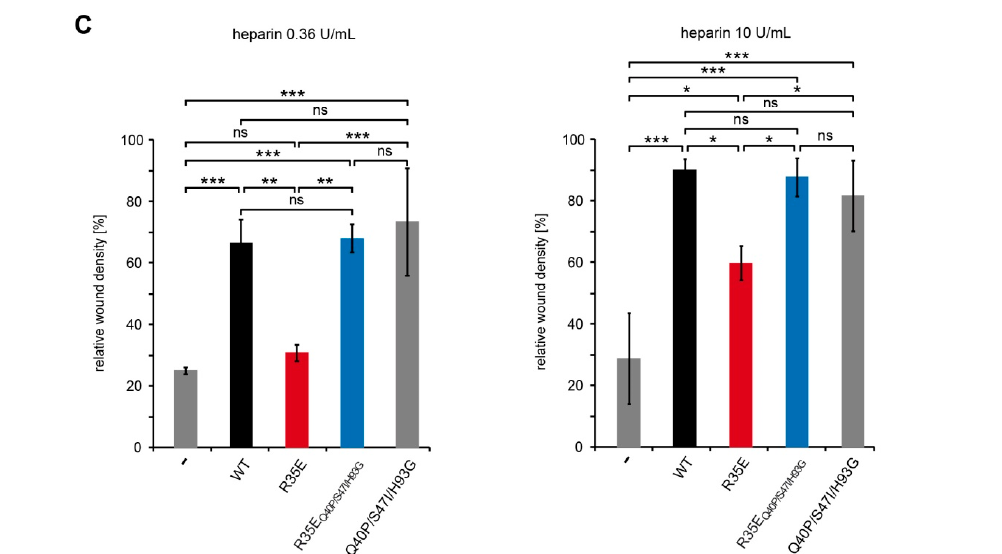
Figure 5. Biological activity of R35E variant depends on heparin concentration. ( A ) The anti-apoptotic activity of R35E variant in the presence of 0.36 U / mL and 10 U / mL of heparin. NIH 3T3 cells starved for 24 h were treated with bovine calf serum or FGF1 variants and the caspase-3 / 7 activity and cell viability were determined using ApoLive-Glo Multiplex Assay. Apoptosis levels were calculated as the ratio of caspase-3 / 7 activity to cell viability and normalized towards untreated cells (relative caspase-3 / 7 activity). The data shown are mean values of three ( n = 3) independent experiments ± SD. Statistical significance: ns—not significant, * p < 0.05, ** p < 0.01, *** p < 0.001. ( B , C ) Effect of FGF1 variants on migration of NIH 3T3 cells. Serum-starved NIH 3T3 cells were treated with FGF1 variants (10 ng / mL) in the presence of heparin (0.36 or 10 U / mL) for 36 h. ( B ) Images of the wounds were obtained by IncuCyte Zoom software ( C ) and the relative wound density was calculated. The data shown are mean values of three ( n = 3) independent experiments ± SD. Statistical significance: ns—not significant, * p < 0.05, ** p < 0.01, *** p <